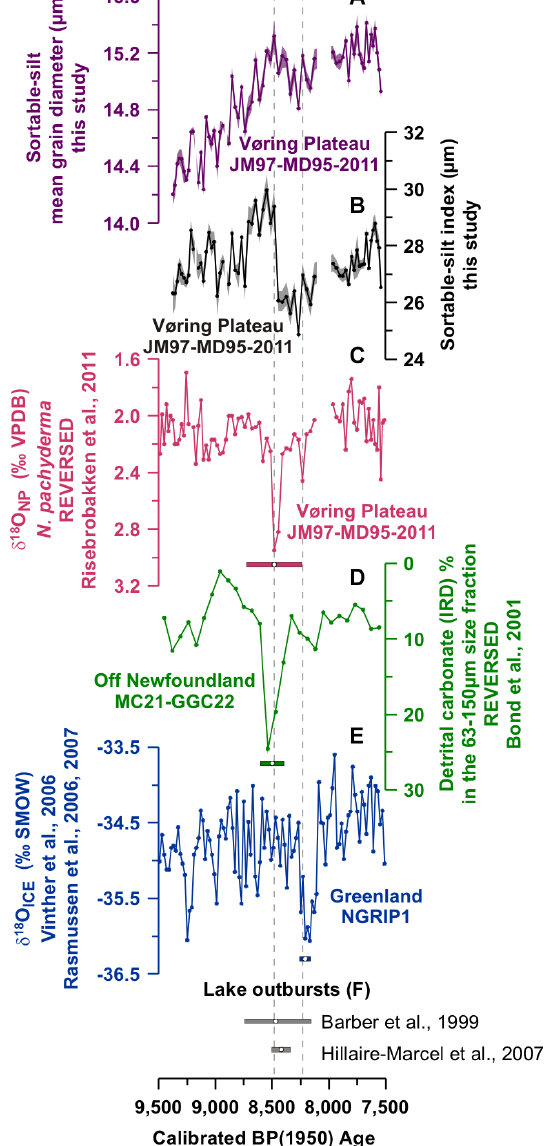
Figure 5. The possible sequence of events following the collapse of the ice dam over Hudson Bay. The slowing-down of the NwASC as suggested (a) by variations in sortable-silt mean grain diameters and (b) by changes in the sortable-silt index. (c) The unique, abrupt (sub)surface-ocean cooling event at 8481 ± 201years BP and the less significant second event at 8233 ± 201years BP at the mid- Norwegian Margin (Risebrobakken et al., 2003e). (d) Ice rafting off Newfoundland (Bond et al., 2008). ( e ) Cooling over Greenland (Rasmussen et al., 2006; Rasmussen et al., 2007; Vinther et al., 2006). (f) Lake outbursts (Barber et al., 1999; Hillaire-Marcel et al., 2007). The horizontal bars below the records denote the ± 1 σ errors in the respective age models. The dashed vertical lines highlight the two (sub)surface-ocean cold events at the Vøring